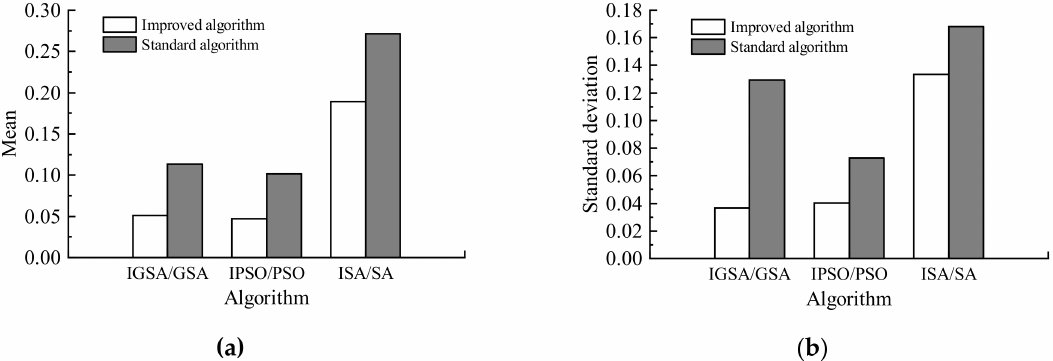
Figure 15. The mean and standard deviation of the objective function. ( a ) Mean; ( b ) Standard